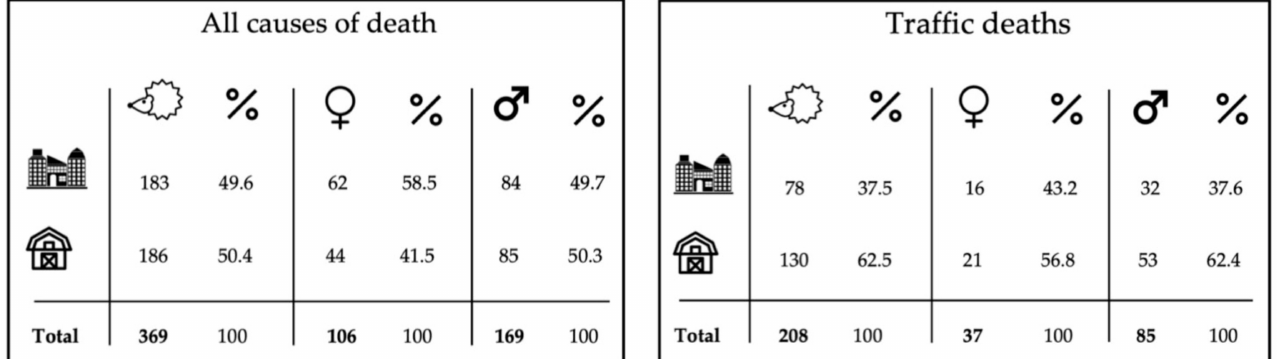
Figure 4. An overview of the dataset showing whether the 369 hedgehogs with geolocations died in rural (barn symbol) or urban (high-rise buildings symbol) habitats, divided into categories of all sexes, including the individuals of unknown sexes (hedgehog symbol), and each separate sex, respectively, including percentage representation of the 208 geolocated traffic-related deaths for each sex and habitat type